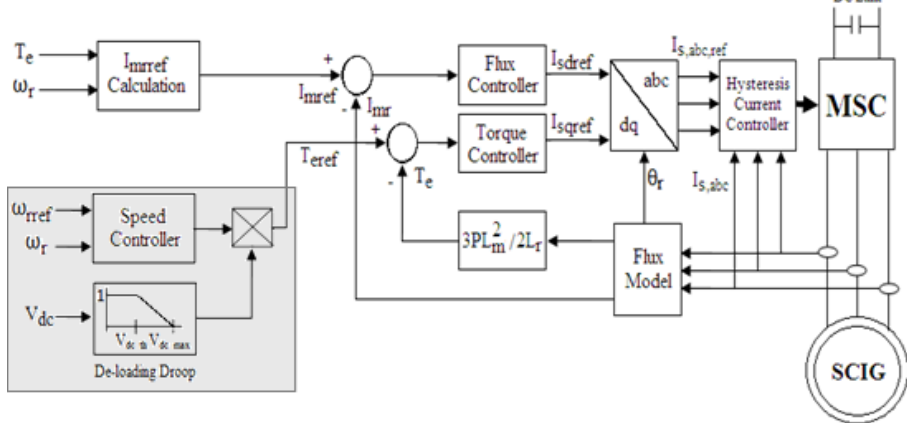
Figure 4. Schematic of Proposed MSC control embedded with a De-Loading Droop.